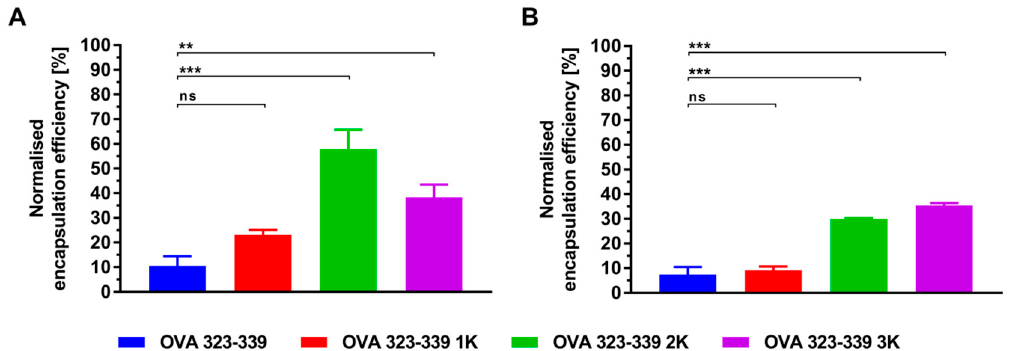
Figure 5. Electrostatically driven encapsulation of cationic peptides into anionic liposomes. Peptide-loaded liposomes were prepared by ( A ) thin-film hydration with subsequent downsizing by means of extrusion or ( B ) microfluidic mixing of an ethanolic lipid solution with an aqueous T helper cell peptide solution. Preparation took place at pH 6.5 under low-ionic-strength conditions (0 mM NaCl / 300 mM sucrose). The initial molar peptide:lipid ratio was 1:667 (7.5 µ M peptide, 5 mM lipid). The encapsulation e ffi ciencies of the liposomes prepared by thin-film hydration were corrected for unspecific binding of non-encapsulated peptide to the membrane of the ultrafiltration unit. As part of that, the level of unspecific binding was normalized to that of OVA 323-339 (8.1 ± 1.9%). The calculated relative reduction in encapsulation e ffi ciency was used to correct / normalize the encapsulation e ffi ciencies of the peptide-loaded liposomes prepared on the microfluidics platform. The non-normalized / non-corrected encapsulation e ffi ciencies are shown in the supplement (Figure S4). Data represent the mean ± standard deviation from three experiments. Statistically significant di ff erences are indicated by asterisks: *** P ≤ 0.001, ** P ≤ 0.01 and ns (not significant), using a one-way ANOVA. A correction for multiple comparisons was made using Tukey’s test.